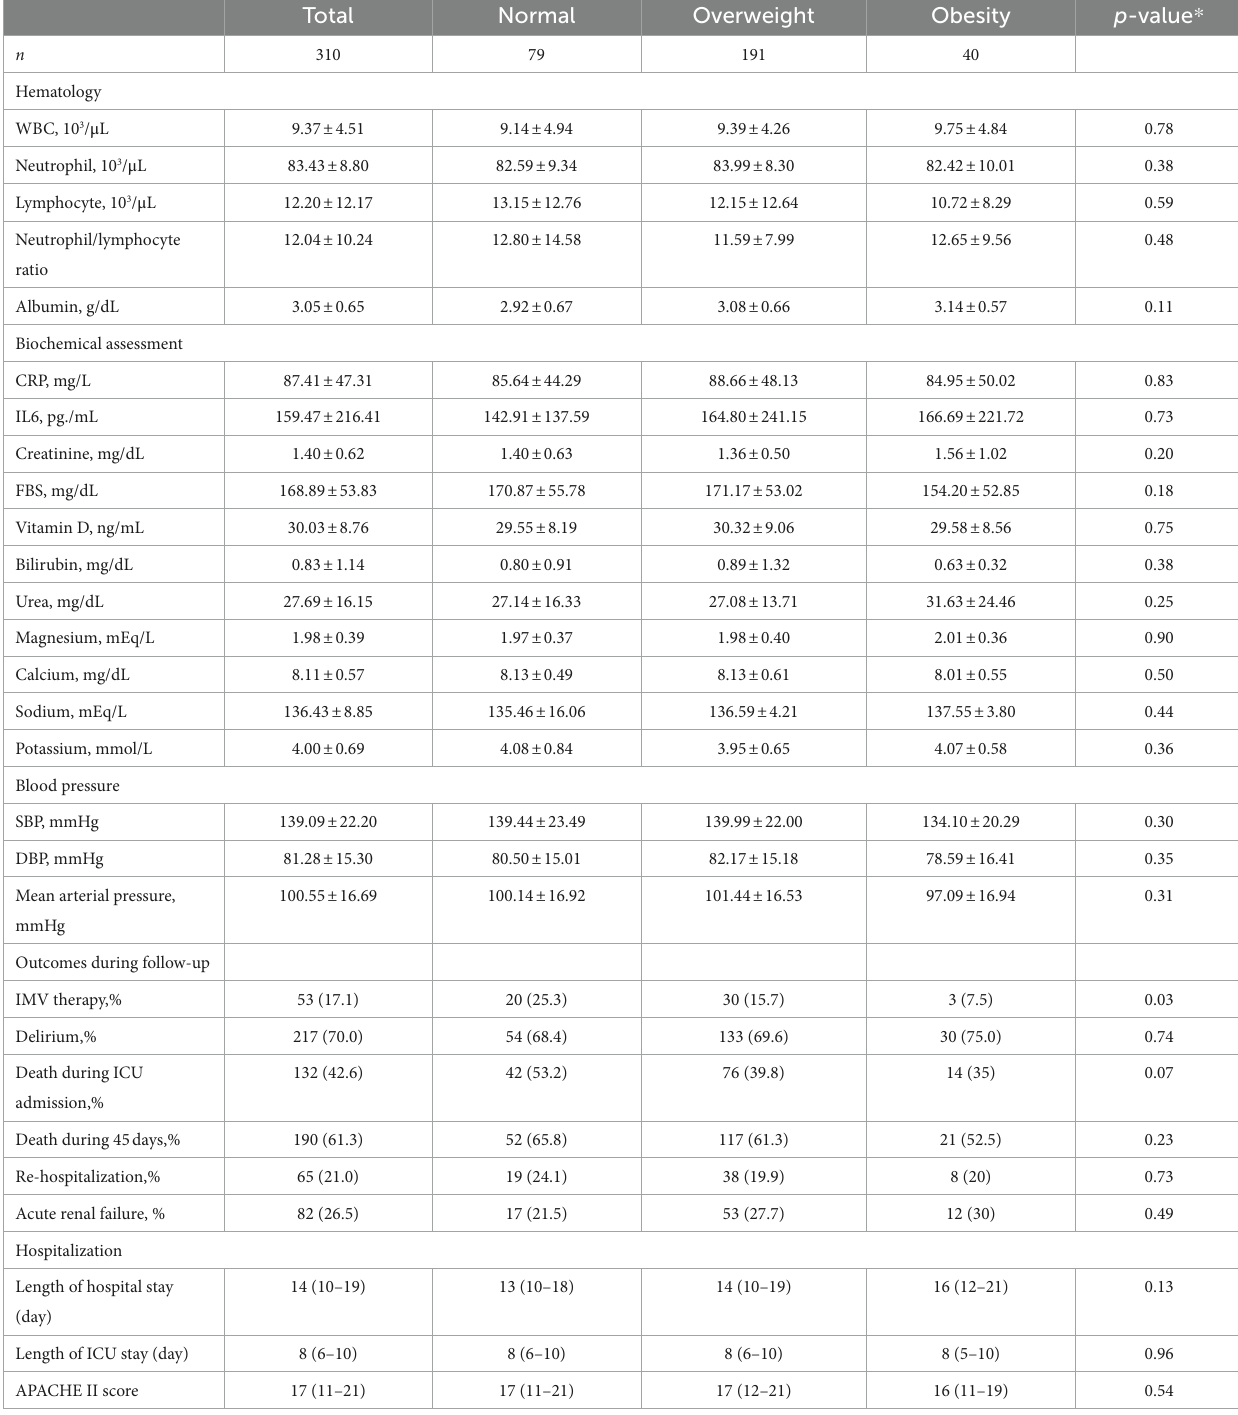
TABLE 2 Clinical characteristics of critically ill elderly patients with COVID-19 across categories of BMI. Total Normal